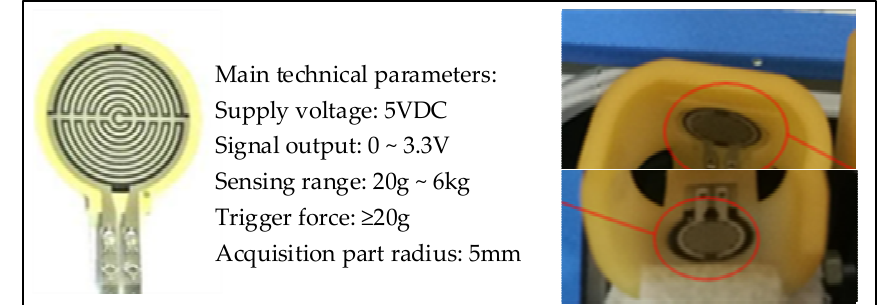
Figure 4. FSR pressure sensor.